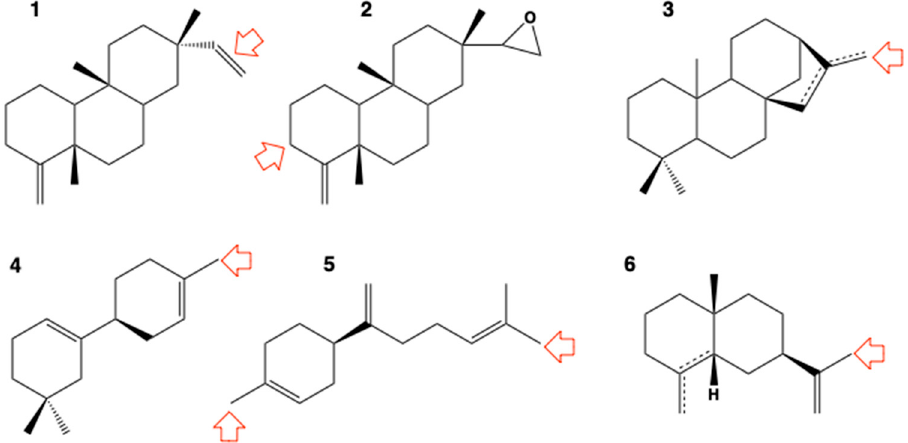
Figure 3. Substrates of the CYP71Z16/18/19 enzymes contributing to four terpenoid defense path- ways in maize. The red arrows indicate the sites of oxidative attack: 1 : dolabriene and 2 : epoxydo- labriene (precursors of dolabralexins); 3 : ent -kaurene or ent -isokaurene (precursors of kauralexins); 4 : β -macrocarpene and 5 : β -bisabolene (precusors of zealexins); 6 : β -selinene (precursor of costics acids). CYP71Z16 and CYP71Z18 were shown to oxidize 1 , 2 , 3 , 4 and 5 . CYP71Z19 was shown to convert 4 , 5 and 6 . β -bisabolene undergoes triple oxidation at the C1 or C15 positions.